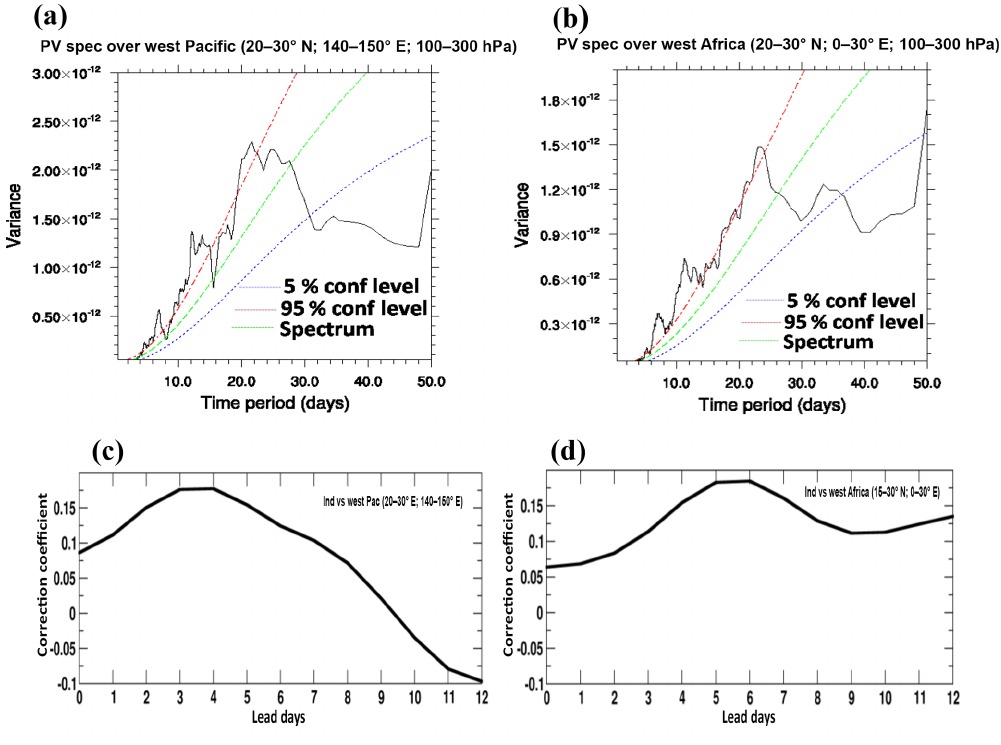
Figure 3. Power spectral analysis of ERA-Interim PV averaged for 100–300hPa and in June–September during 1995–2015 for (a) western Africa (20–30 ◦ N, 0–30 ◦ E) and (b) western Pacific (20–30 ◦ N, 140–150 ◦ E) and lag–lead Pearson correlation coefficient of PV in the monsoon anticyclone (85–90 ◦ E, 28–30 ◦ N) with (c) western Pacific (20–30 ◦ N, 140–150 ◦ E) and (d) western Africa (20–30 ◦ N, 0–30 ◦ E). In (a) – (b) the dotted green line indicates the spectrum and blue and red lines indicate 5% and 95% confidence levels for lag-1 autocorrelation. Any spectral peak above the red line is statistically significant at the 95% confidence